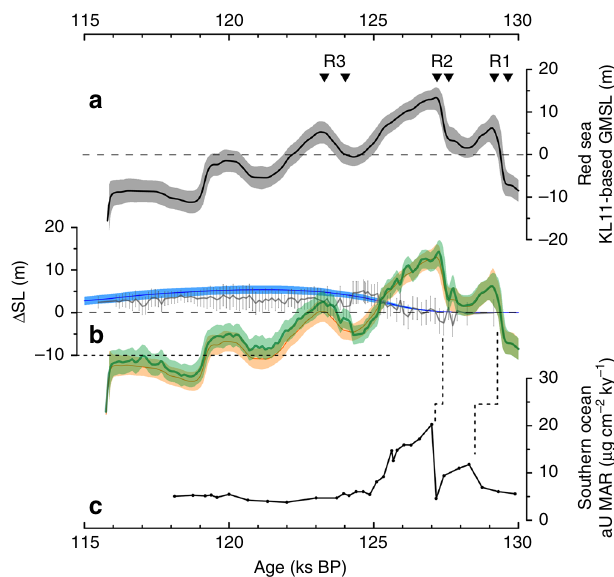
Fig. 3 Identi fi cation of Greenland Ice Sheet and Antarctic Ice Sheet contributions to Last Interglacial sea-level variations. a Global Mean Sea Level (GMSL) approximation based on the probabilistically assessed KL11 PM (black line) and its 95% probability interval (grey). This record is shown in terms of RSL in Fig. 2f, but here includes the glacio-isostatic correction and its propagated uncertainty. Black triangles identify limits between which sea-level rises R1, R2, and R3 were measured. Rates of rise with 95% bounds: R1 = 2.8 (1.2 – 3.7) m c − 1 ; R2 = 2.3 (0.9 – 3.5) m c − 1 ; R3 = 0.6 (0.1 – 1.3) m c − 1 . b Blue: GrIS sea-level contribution from the model-data assimilation of ref. 9 (shading represents the 95% probability interval). Grey: GrIS contribution based on Eirik Drift δ 18 O sw . Uncertainties as in Fig. 2a. Orange: AIS contribution from subtraction of the blue GrIS reconstruction from the record in a . Green: AIS contribution found by subtracting the grey GrIS reconstruction from the record in a . Orange and green AIS reconstructions are shown as medians (lines) and 95% con fi dence intervals (shading). Reconstructed AIS contributions cross downward through a fi ne dashed when they fall below – 10 m, which indicates a rough maximum AIS growth limit in terms of sea-level lowering (AIS growth is limited by Antarctic continental shelf edges). When the green/orange curves fall below these limits, North American and/or Eurasian ice-sheet growth is likely implied. The key result from the present study lies in identi fi cation of GrIS and AIS sea-level contributions above 0 m. c Southern Ocean ODP (Ocean Drilling Program) Site 1094 authigenic uranium mass accumulation rates, on its original, Antarctic Ice Core Chronology (AICC2012) tuned, age model. Dashed lines indicate potential offsets (within uncertainties) between the ODP 1094 AICC2012-based chronology 36 and our LIG chronology (see refs. 10,19 and this